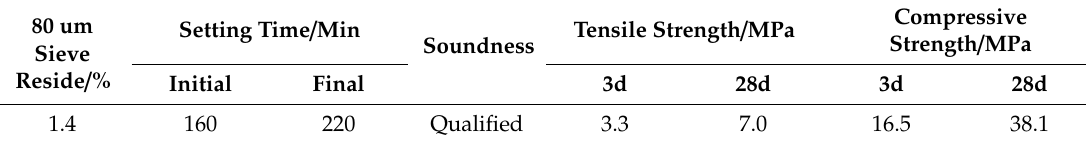
Table 1. Physical properties of cement.